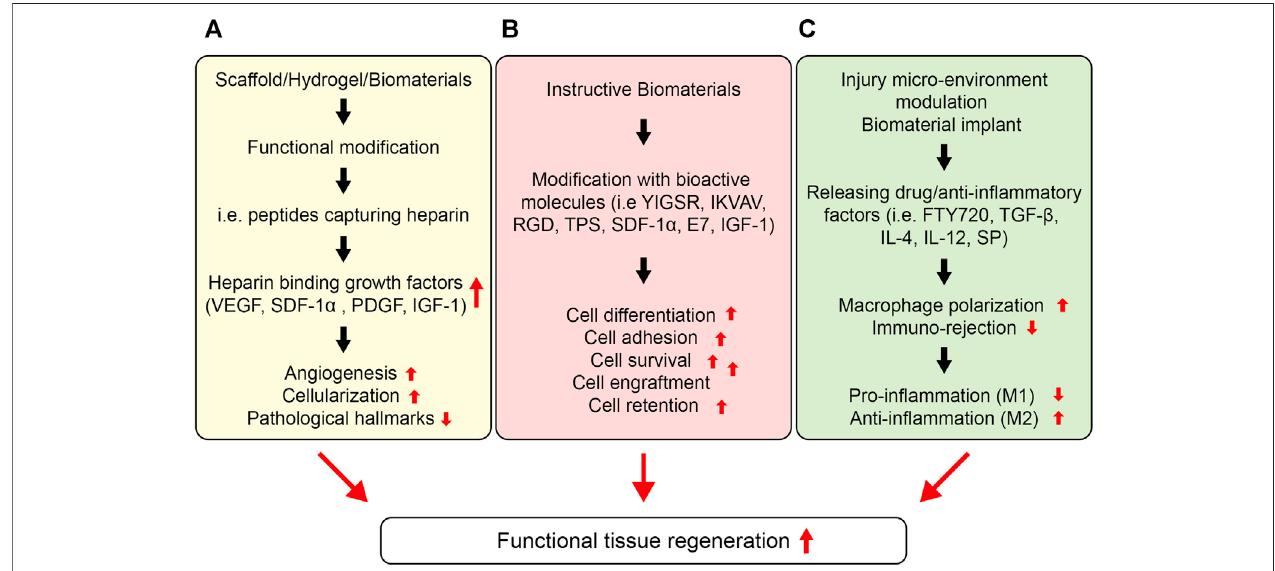
FIGURE6| Strategiestoenhancecellfunctionforafunctionaltissuerepair. (A) Stemcellfunctioncanbeimprovedbysequesteringproteins insitu viathefunctional design of biomaterials. Different types of peptides could be installed into biomaterials with the ability to endogenously capture cell-signaling proteins, such as heparin, which can then bind several heparin-binding growth factors, such as, VEGF, PDGF, IGF etc. (B) Instructive biomaterials designed by incorporating bioactive cues can also enhance cell survival, retention, and engraftment. Depending upon the nature of the signaling cue, they can enhance the stem cell differentiation, proliferation, or migration in vitro and in vivo , which can be central to the formation of in vitro tissue-engineered constructs as well as enhance cell engraftment in vivo . (C) The injury microenvironment can also be tuned to ameliorate stem cell function, including survival, retention, and engraftment. This can be achieved by releasing anti-in fl ammatory therapeutics and cytokines, including IL-4, IL-1, TGF- β 1, rapamycin, resveratrol, SP etc. Consequently, these therapeutics and functional cues can lower the pro- in fl ammatory response and enhance the anti-in fl ammatory response overcoming the immune rejection, lowering the fi brosis, and enhancing the stem cell survival and retention as well as engraftment at the targeted